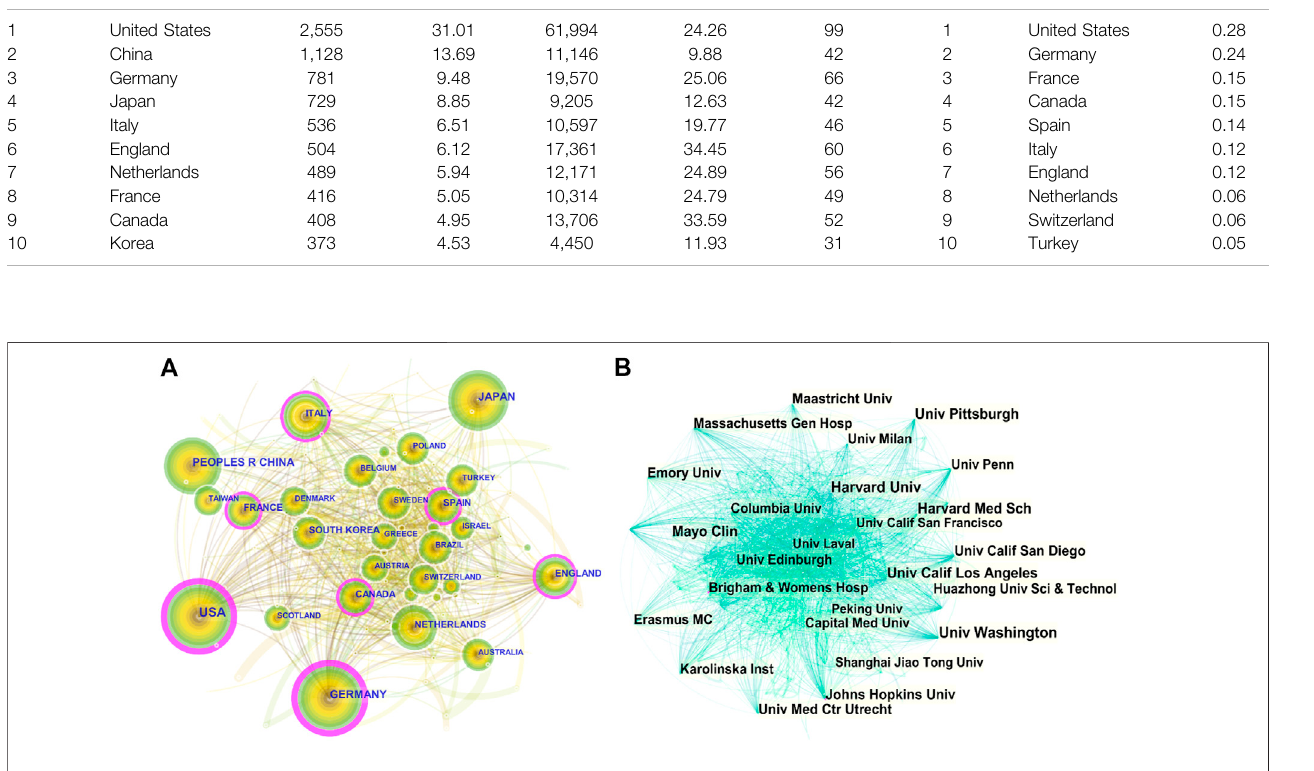
FIGURE 2 | CiteSpace visualization map of countries and institutions involved in vascular calci fi cation research. (A) Collaboration network of countries. N (cid:1) 104, E (cid:1) 798. N represents the number of network nodes. E represents the number of connections. (B) Collaboration network of institutions. N (cid:1) 480, E (cid:1) 3,382.